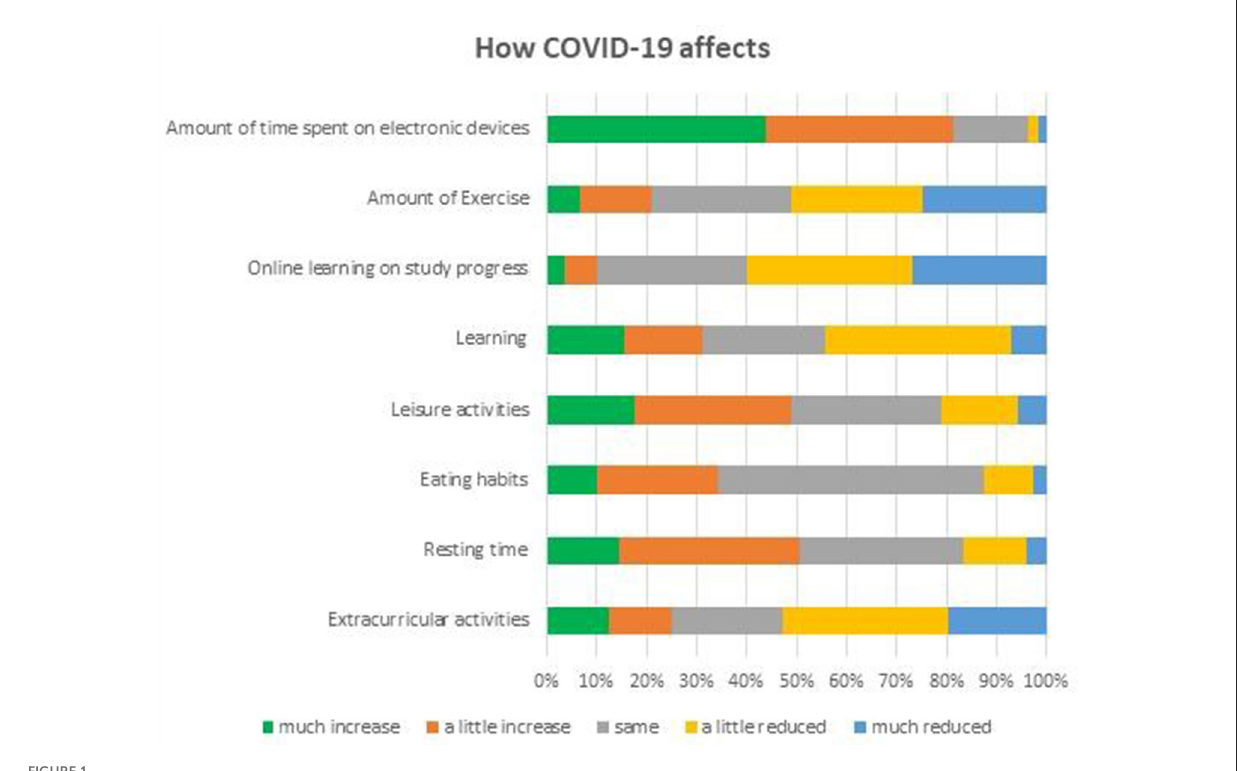
FIGURE1 The effect of COVID-19 on the participants’ daily life and health.